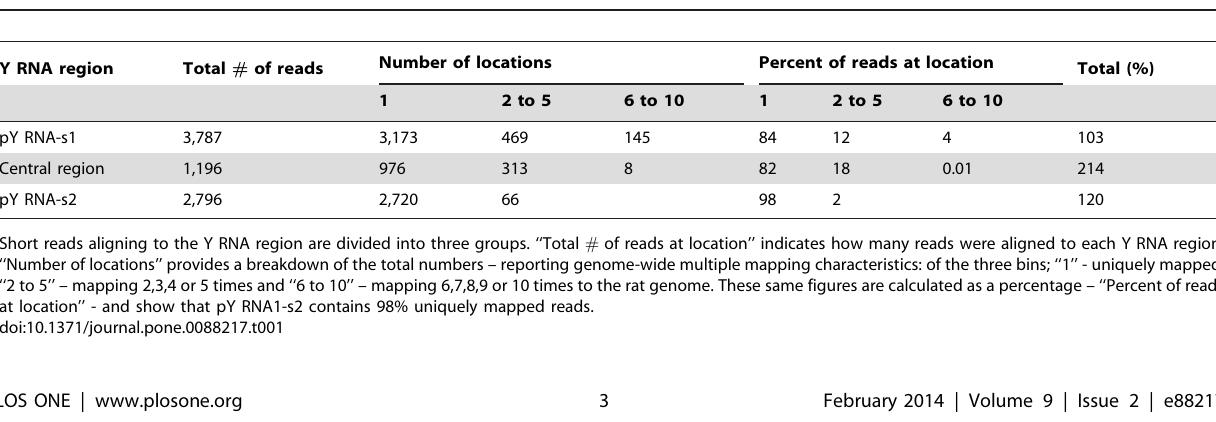
Table 1. Distribution of pineal RNA sequencing reads mapping for Y RNA regions.